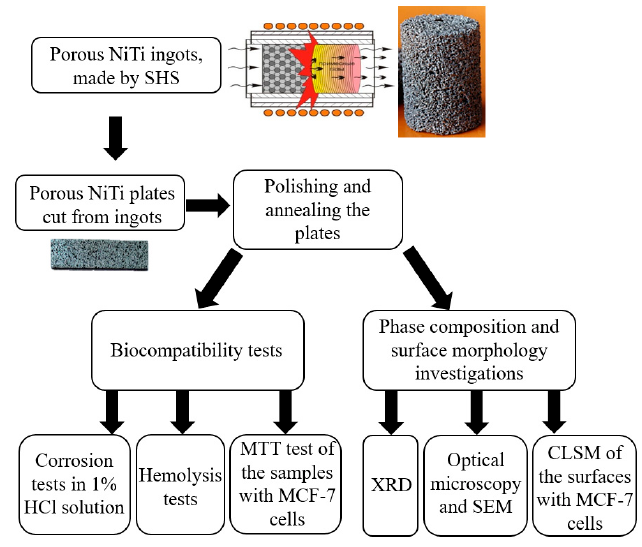
Figure 1. The scheme of the experimental testing.